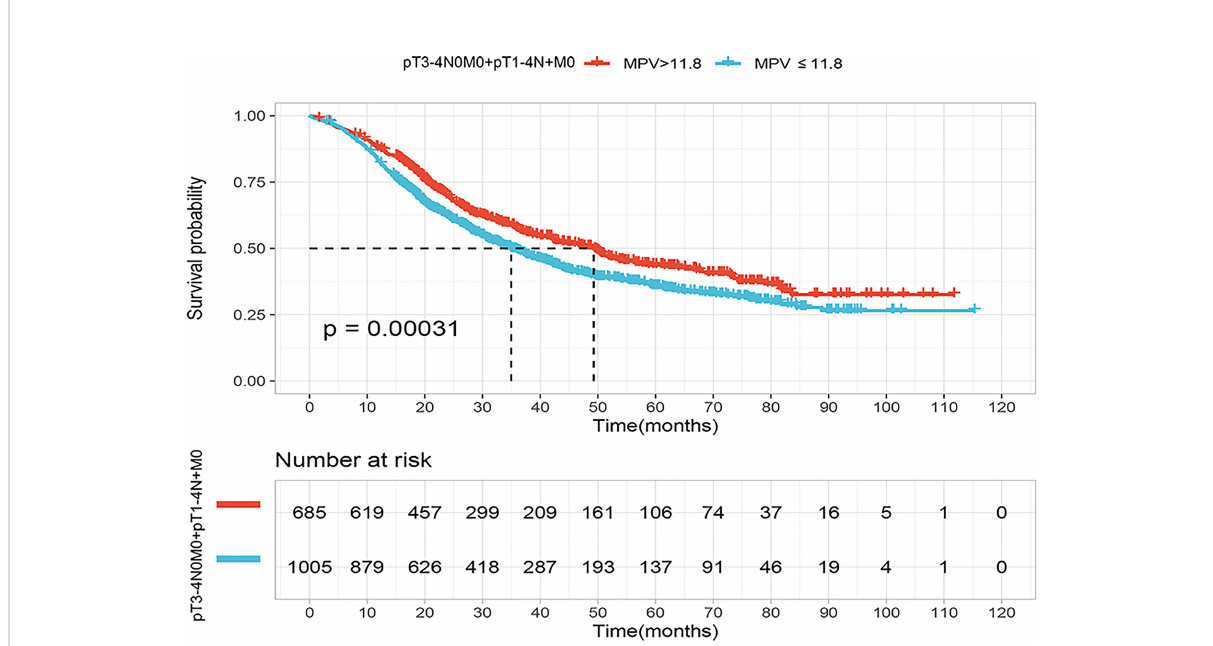
FIGURE 2 Kaplan – Meier curves for overall survival (OS) of the patients according to the mean platelet volume (MPV) cutoff value (11.8fL) in the locally advanced cohort